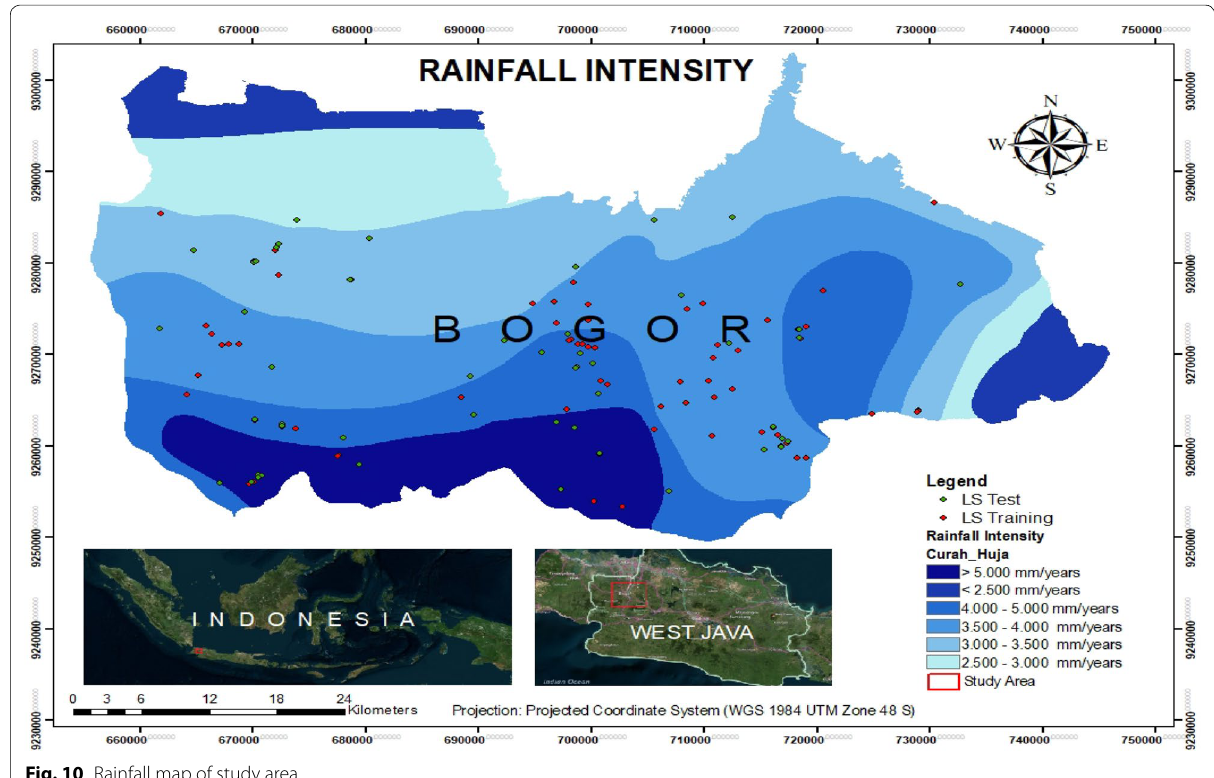
Fig. 10 Rainfall map of study area